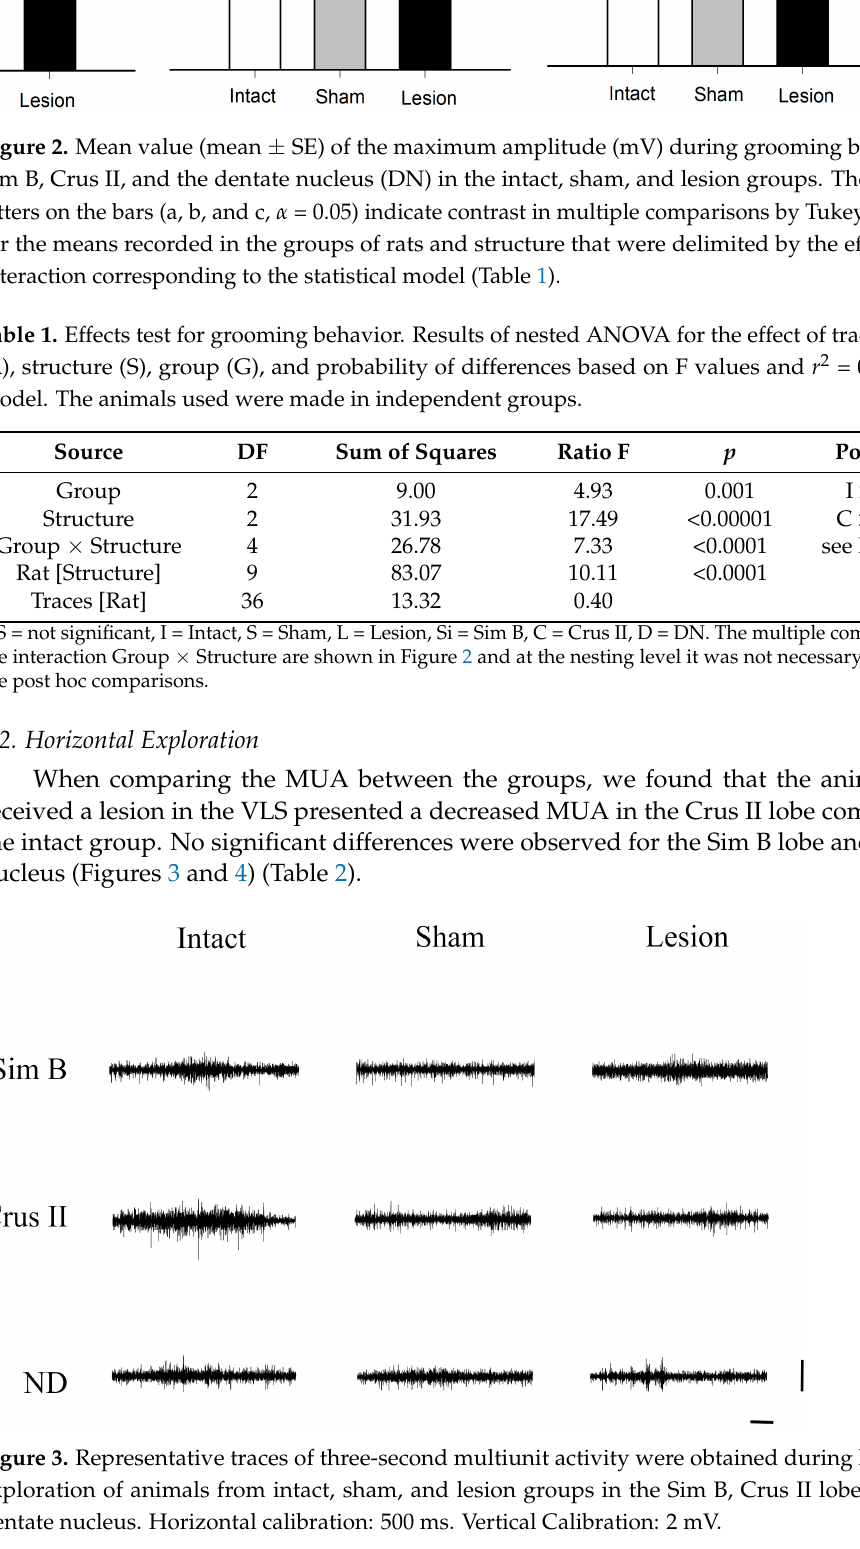
Figure 4. Mean value (mean ± SE) of the maximum amplitude (mV) during horizontal exploration of the Sim B, Crus II structures, and the dentate nucleus (DN) in the intact, sham, and lesion groups. The different letters on the bars (a, b, and c, α = 0.05) indicate contrast in multiple comparisons by Tukey’s method for the means recorded in the groups of rats and structure that were delimited by the effect of the interaction corresponding to the statistical model (Table 2). Table 2. Effects test for horizontal exploration behavior. Results of nested ANOVA for the effect of traces (T), rat (R), structure (S), group (G), and probability of differences based on F values and r 2 = 0.33 of the model. The animals used were made in independent groups. Source